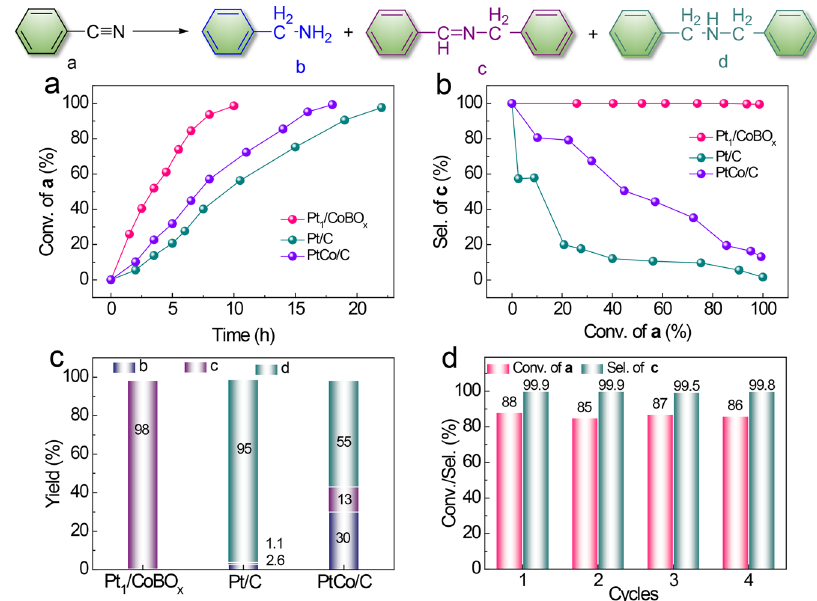
Fig. 3 Catalytic performance of the Pt 1 /CoBO x , Pt/C, and PtCo/C catalysts. a Time course of benzonitrile conversions. b Benzonitrile conversion vs . selectivity of secondary imines. c Final yield of various products. d Stability of Pt 1 /CoBO x . Reaction conditions: benzonitrile (1 mmol), isopropanol (2 mL), catalysts (5 mg), 90 °C, and 1 MPa H 2 . The reaction time of the stability test was 8